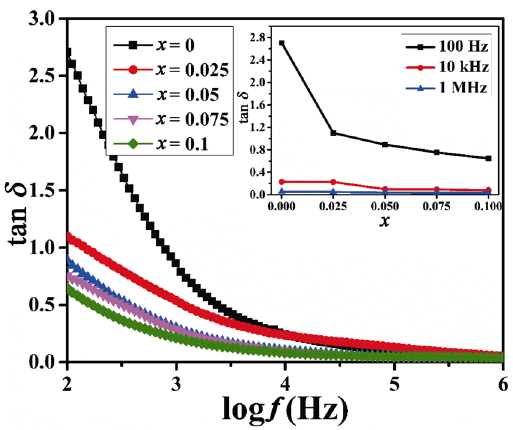
Fig. 9 Variation of dielectric loss of Mn 0.5 Zn 0.5 Gd x Fe 2– x O 4 ( x = 0, 0.025, 0.050, 0.075, and 0.10) with frequency.